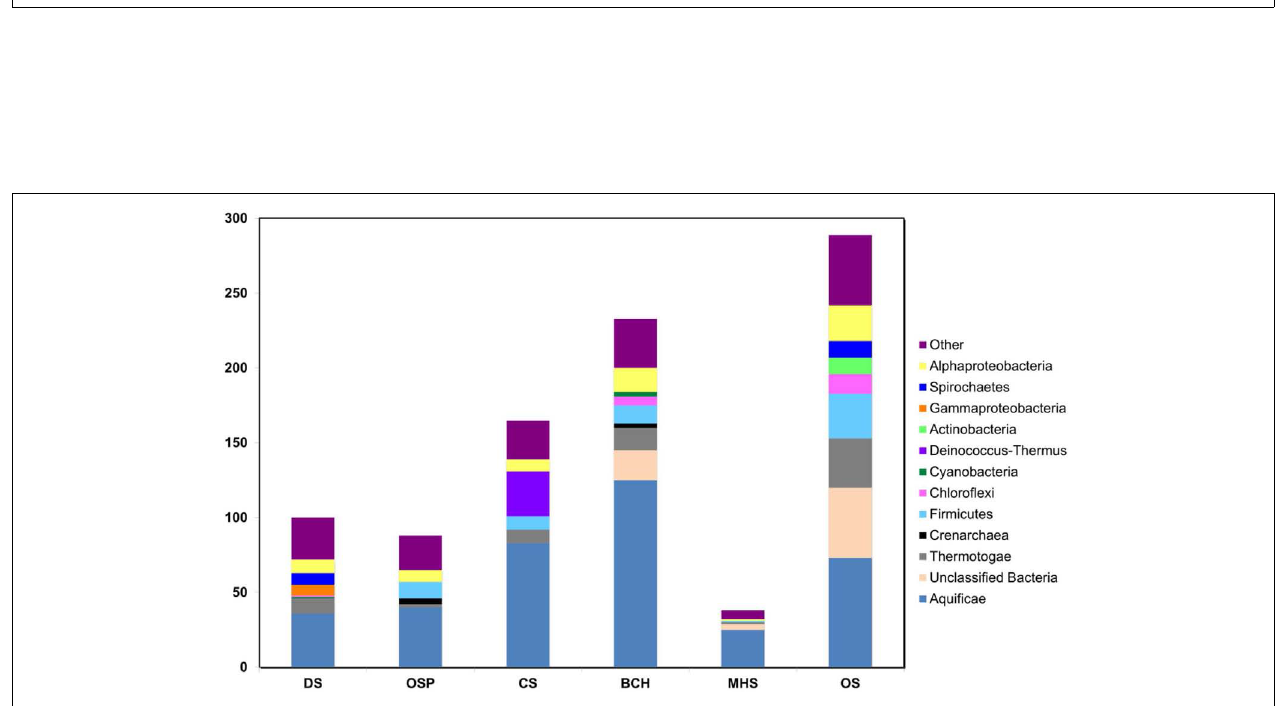
FIGUREA5 | Consensus phylogenetic classification (AMPHORA;Wu and Eisen, 2008) of assembled sequence using analysis of 31 housekeeping genes . Although the Aquificales are the dominant members of each streamer sample, diverse and novel members of other bacterial and archaeal lineages are predicted to vary in abundance across